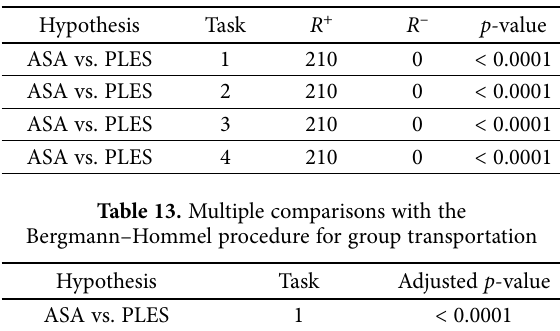
Table 12. Pairwise comparisons with the Wilcoxon test for group transportation